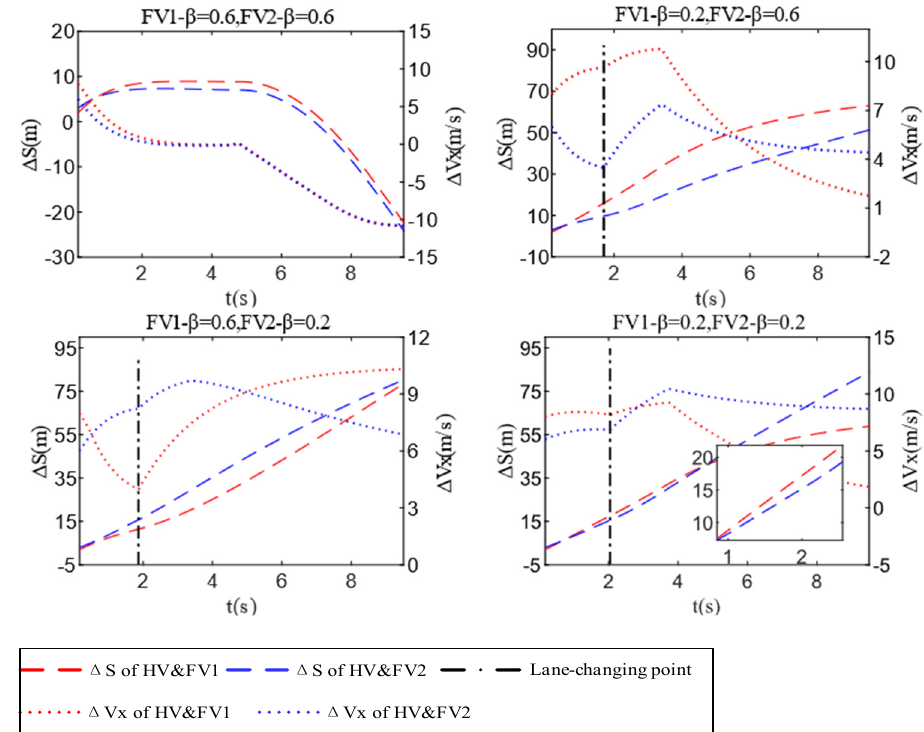
Figure 15. Test results of relative distance and relative velocity of scenario B.